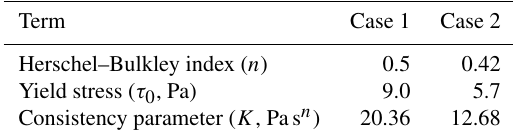
Table 5. Parameters of the time-independent fluid model.